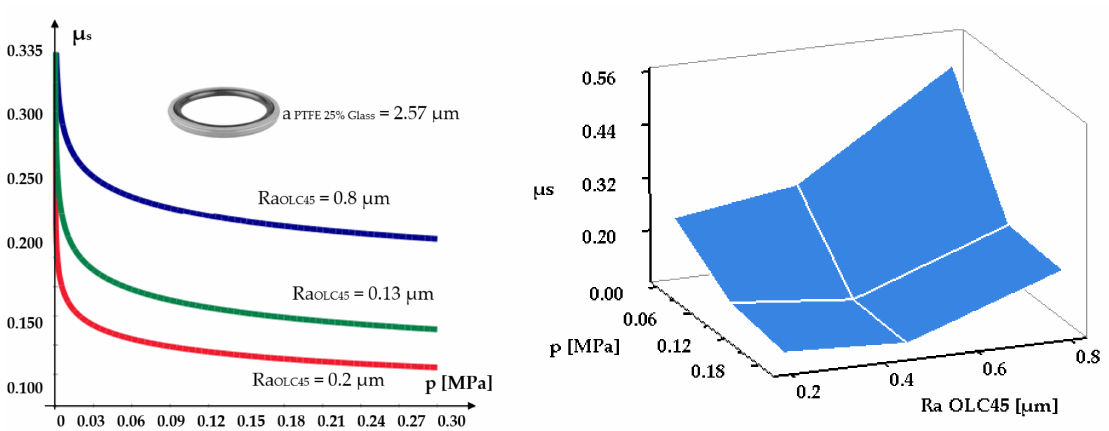
Figure 5. Dependency of the static friction coefficient on contact pressure and surface roughness for the material pair OLC45/PTFE 25%